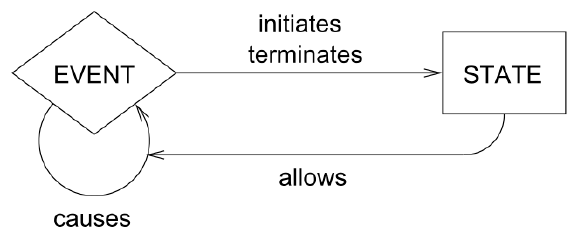
Figure 19. Causal and causal-like relations between states and events [102] .